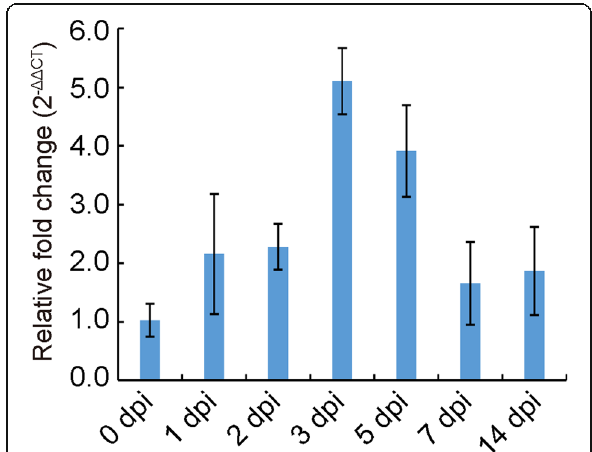
Fig. 5 Expression pattern of UvCAP1 during the infection process of U. virens . The inoculated panicle at 0, 1, 2, 3, 5, 7 and 14 dpi were collected to detect the expression level of UvCAP1 . RT-qPCR was performed with five biological replicates; β - TUBULIN gene was used as the reference gene. Error bars represent SD